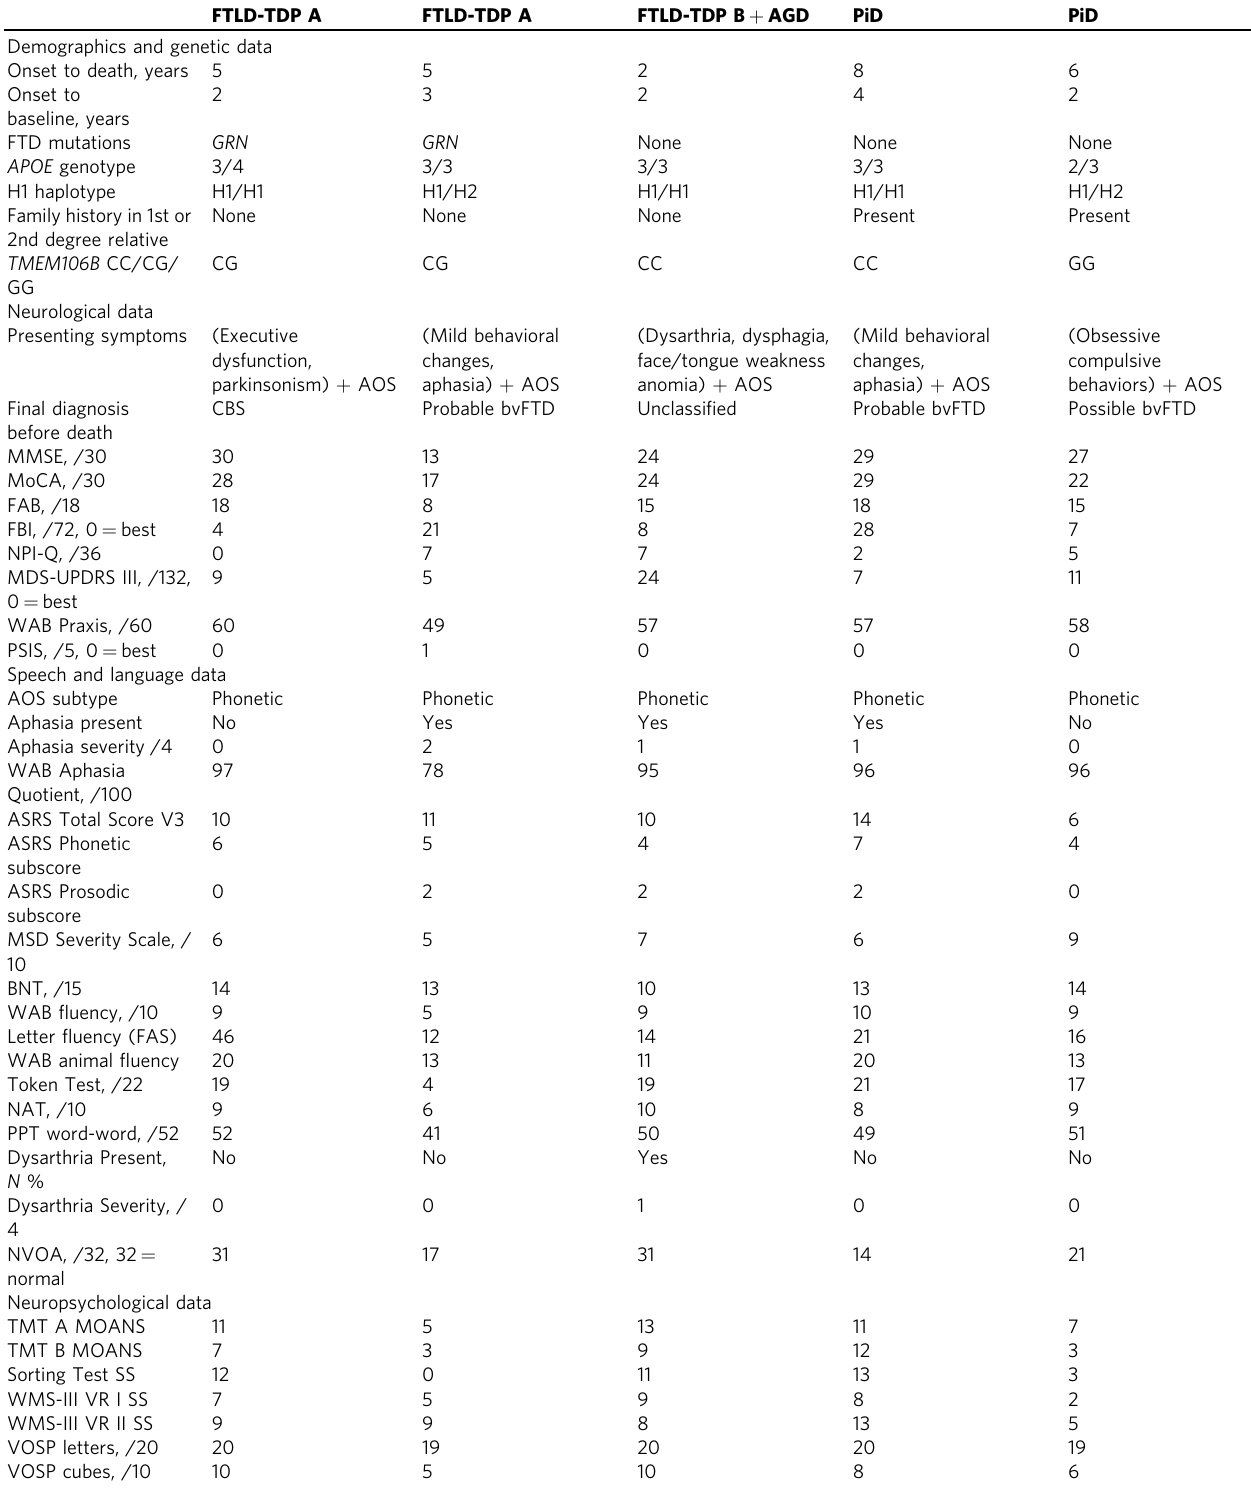
Table 2 Baseline demographic and clinical features for the fi ve + AOS cases with FTLD-TDP, PiD, and AGD pathology. FTLD-TDP A PiD Demographics and genetic data Onset to death, years